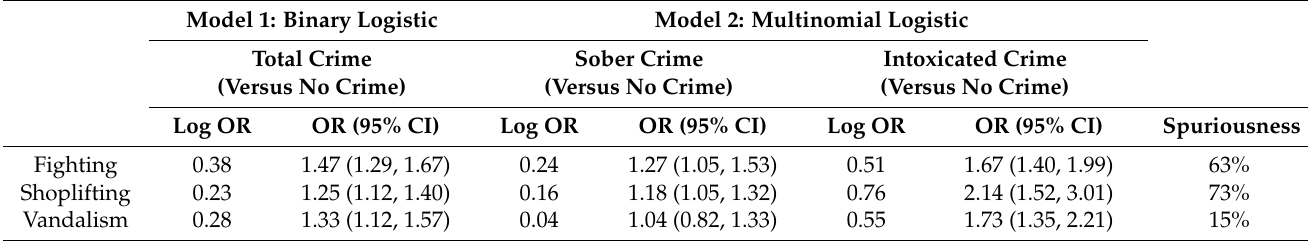
Table 3. Multivariable associations between typical alcohol consumption (treated as a numeric variable) and total crime (model 1), sober crime (model 2), and crime under the influence of alcohol (model 2). Model 1: Binary Logistic Model 2: Multinomial